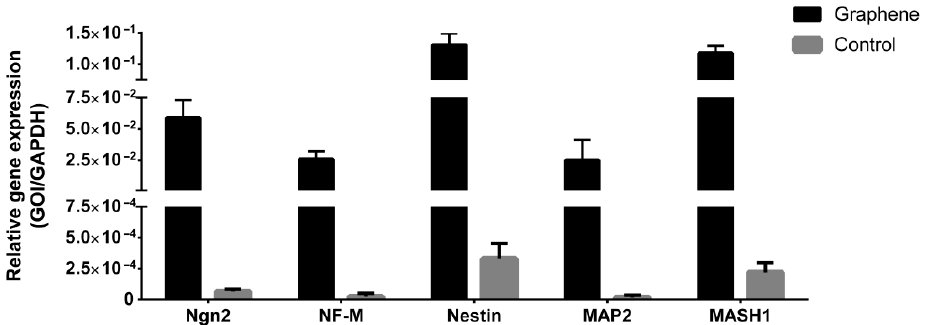
Figure 12. SEM of SCAP grown on graphene film. ( a ) Triangular cell body with arising long-distance membrane projections; ( b ) Slender cell projections synapsing with adjacent cell.